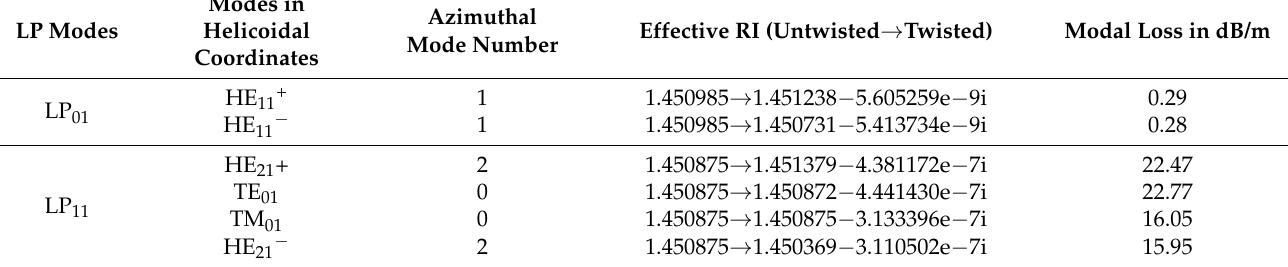
Table 1. Degeneracy breaking of the linearly polarized LP mn mode group, increment of the effective RI from an untwisted ( n eff ) to twisted ( n ) fiber, and modal losses of a twisted octagon-shaped core fiber with R = 25 μm, NA = 0.065, Λ = 4.2 mm, and λ = 1064 nm.